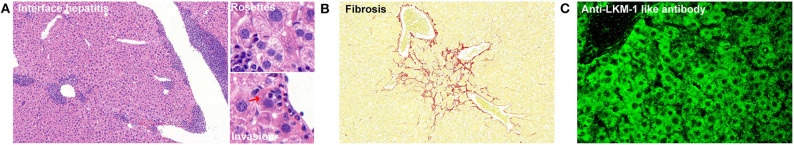
Characteristic features of type 2 AIH in an improved mouse model. (A) Chronic liver inflammation (interface hepatitis) and characteristic pathological features (rosettes and lymphocytes invasion) are shown. The red arrow indicates the hepatocyte. (B) Sirius red staining showing the fibrosis in a mouse liver. The red color indicates collagenous fibers. (C) Stained autoantibodies from the plasma of AIH mice.